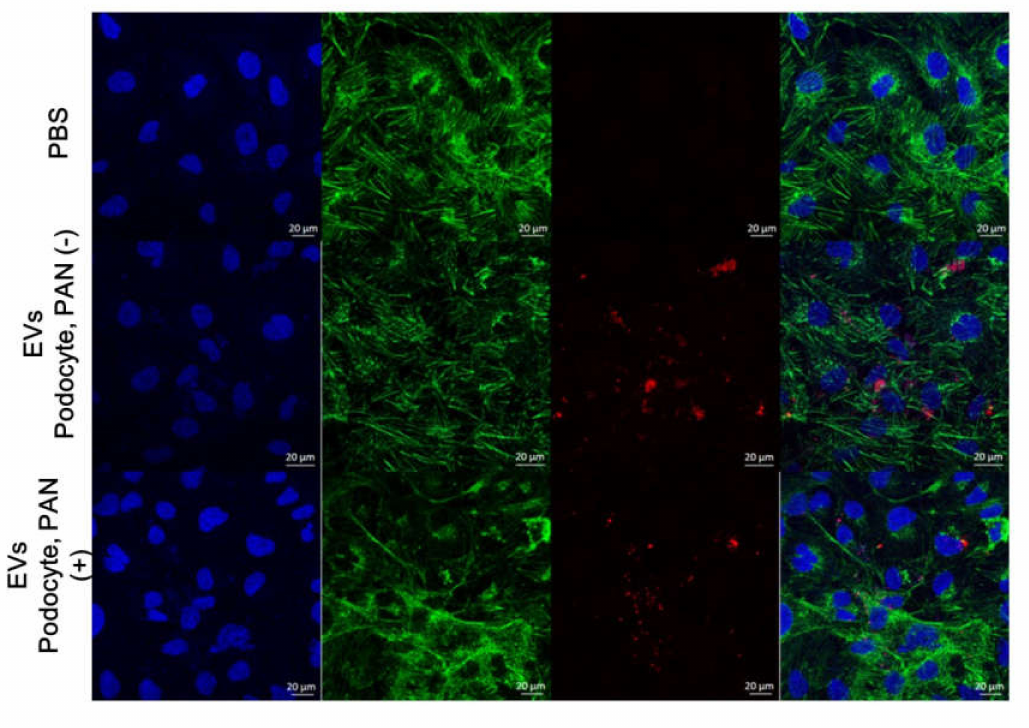
Figure 2. HK2 cells interact with EVs. Confocal microscopy showed that EVs of PKH26-labelled (red) from podocytes (PAN-treated or untreated) were visible with HK2 cells. Filamentous actin was stained with phalloidin (green) and nucleoli were labelled with 4 (cid:48) ,6-diamidino-2-phenylindole (DAPI)